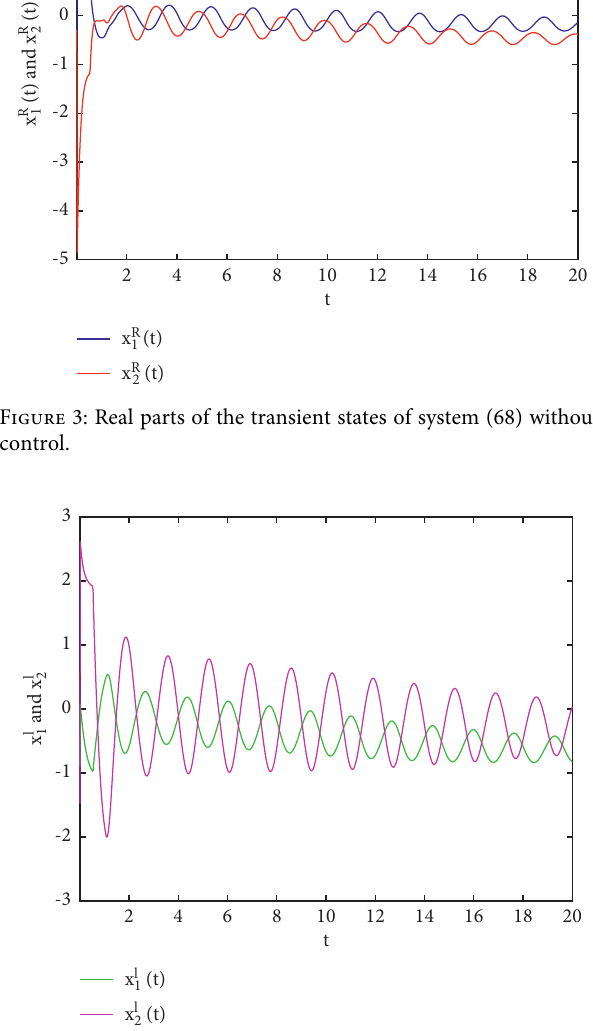
Figure 4: Imaginary parts of the transient states of system (68) without control.